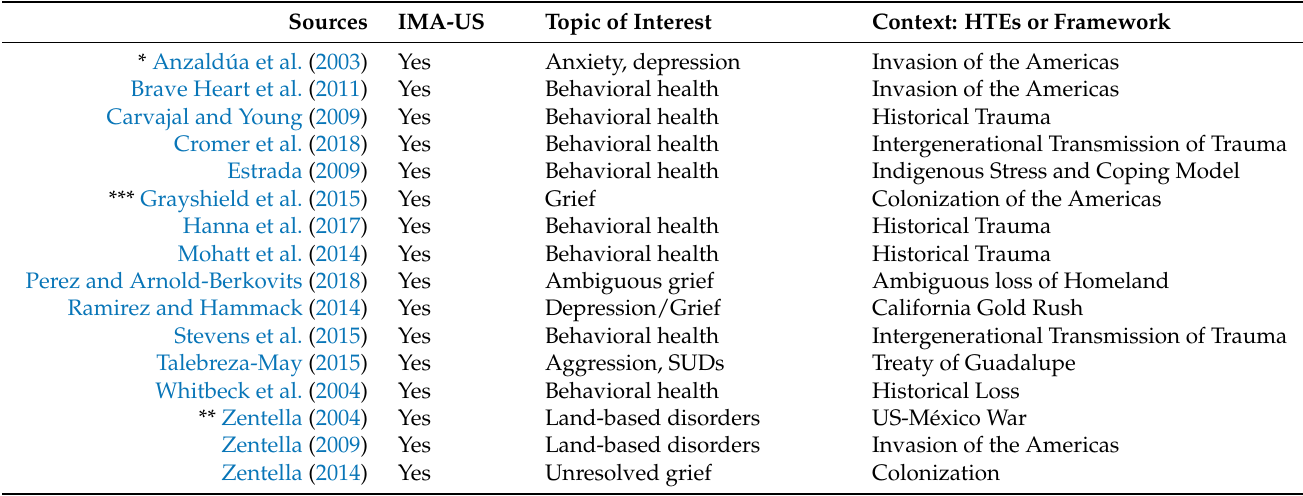
Table 1. Selected sources. Population, Topic of Interest, and Context under which the topic of interest is examined. Sources IMA-US Topic of Interest Context: HTEs or